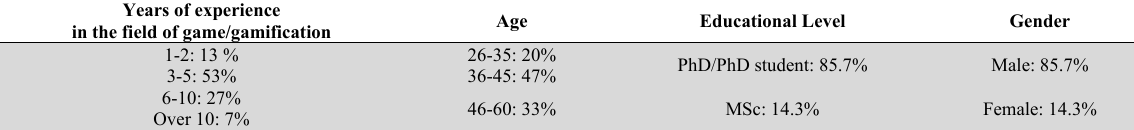
Demographic of experts Years of experience in the field of game/gamification